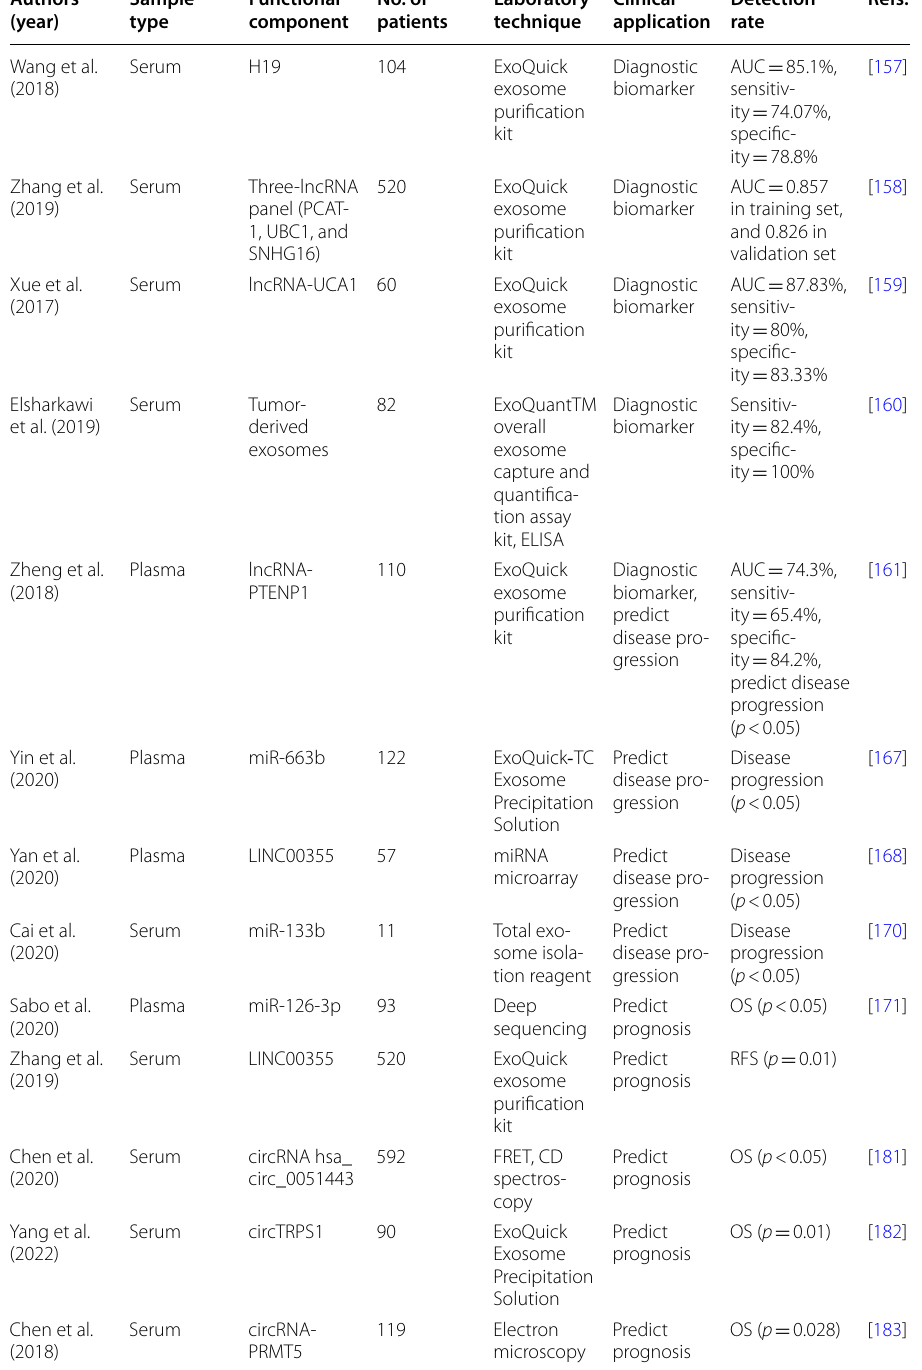
miRNA microRNA, circRNA circular RNA, lncRNA long non-coding RNA, AUC area under the receiver operating characteristics curve, ELISA enzyme linked immunosorbent assay, OS overall survival, RFS recurrence-free